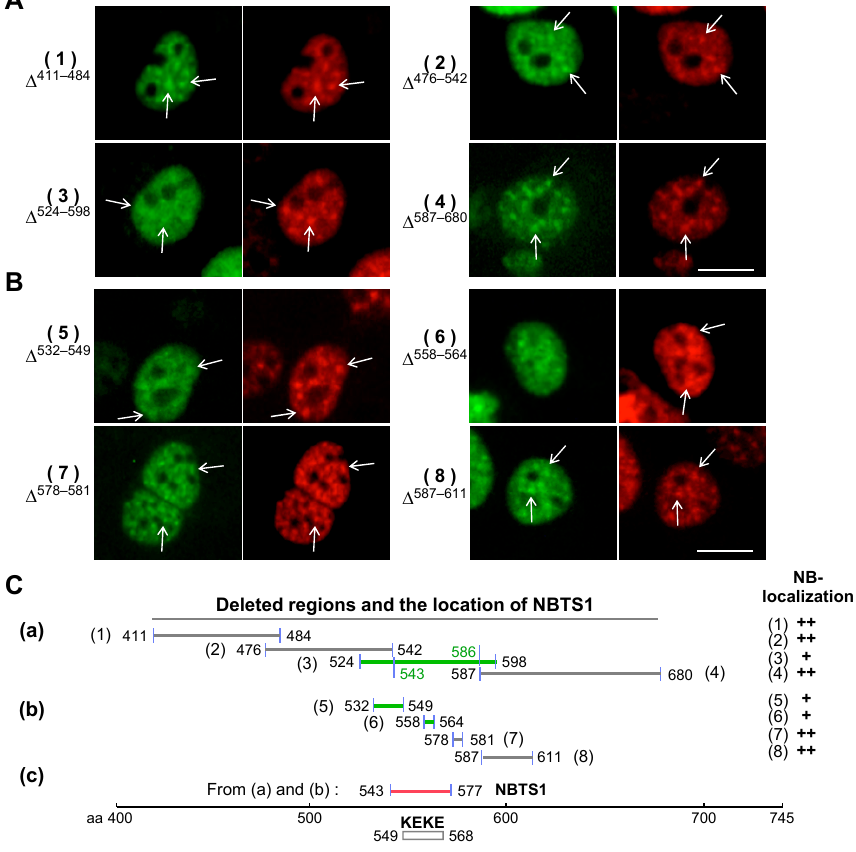
Figure 2. Identification of NBTS1 in aa 543–577. ( A , B ) Constructs 1–4 in A and 5–8 in B were derived from pRBM10/EGFP-N1 by deleting the regions indicated, and expressed in ARL cells. Green, EGFP; red, RBM10 stained with anti-S1-1/RBM10 antiserum. Some S1-1 NBs are indicated by arrows. Scale bar: 10 µ m. ( C ) Deleted regions and summary of results. Horizontal lines in (a) and (b) indicate deleted regions in the constructs examined in A and B, with corresponding residue numbers provided at each end. Green lines indicate constructs whose products showed weak or indistinct localization to S1-1 NBs. (c) Location of NBTS1 in RBM10. The results in (a) and (b) were combined to locate NBTS1 on RBM10. It is present in aa 543–577 (red line), which correspond to the KEKE motif